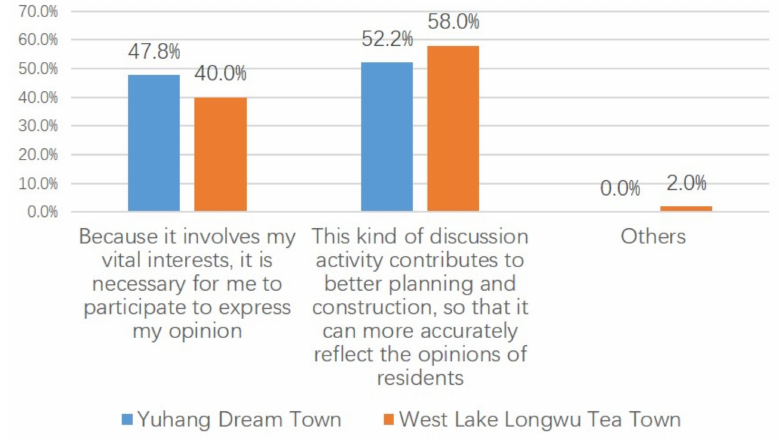
Figure 25. Reasons why respondents are willing to participate in discussion activities on the planning and construction of the local CT practice (source: authors).